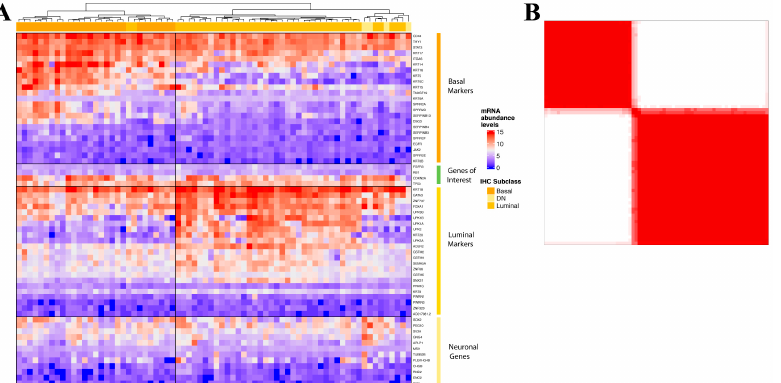
Figure 1. ( A ) Unsupervised hierarchical clustering (Pearson correlation) of normalized abundance levels of 62 mRNAs derived by NanoString nCounter assay for Cohort I. Annotation of immuno- histochemical subtypes is indicated for reference; ( B ) consensus matrix (k = 2) for Cohort I where samples represent rows and columns. The consensus values range from 0 denoted in white (never clustered together) to 1 denoted in red (always clustered